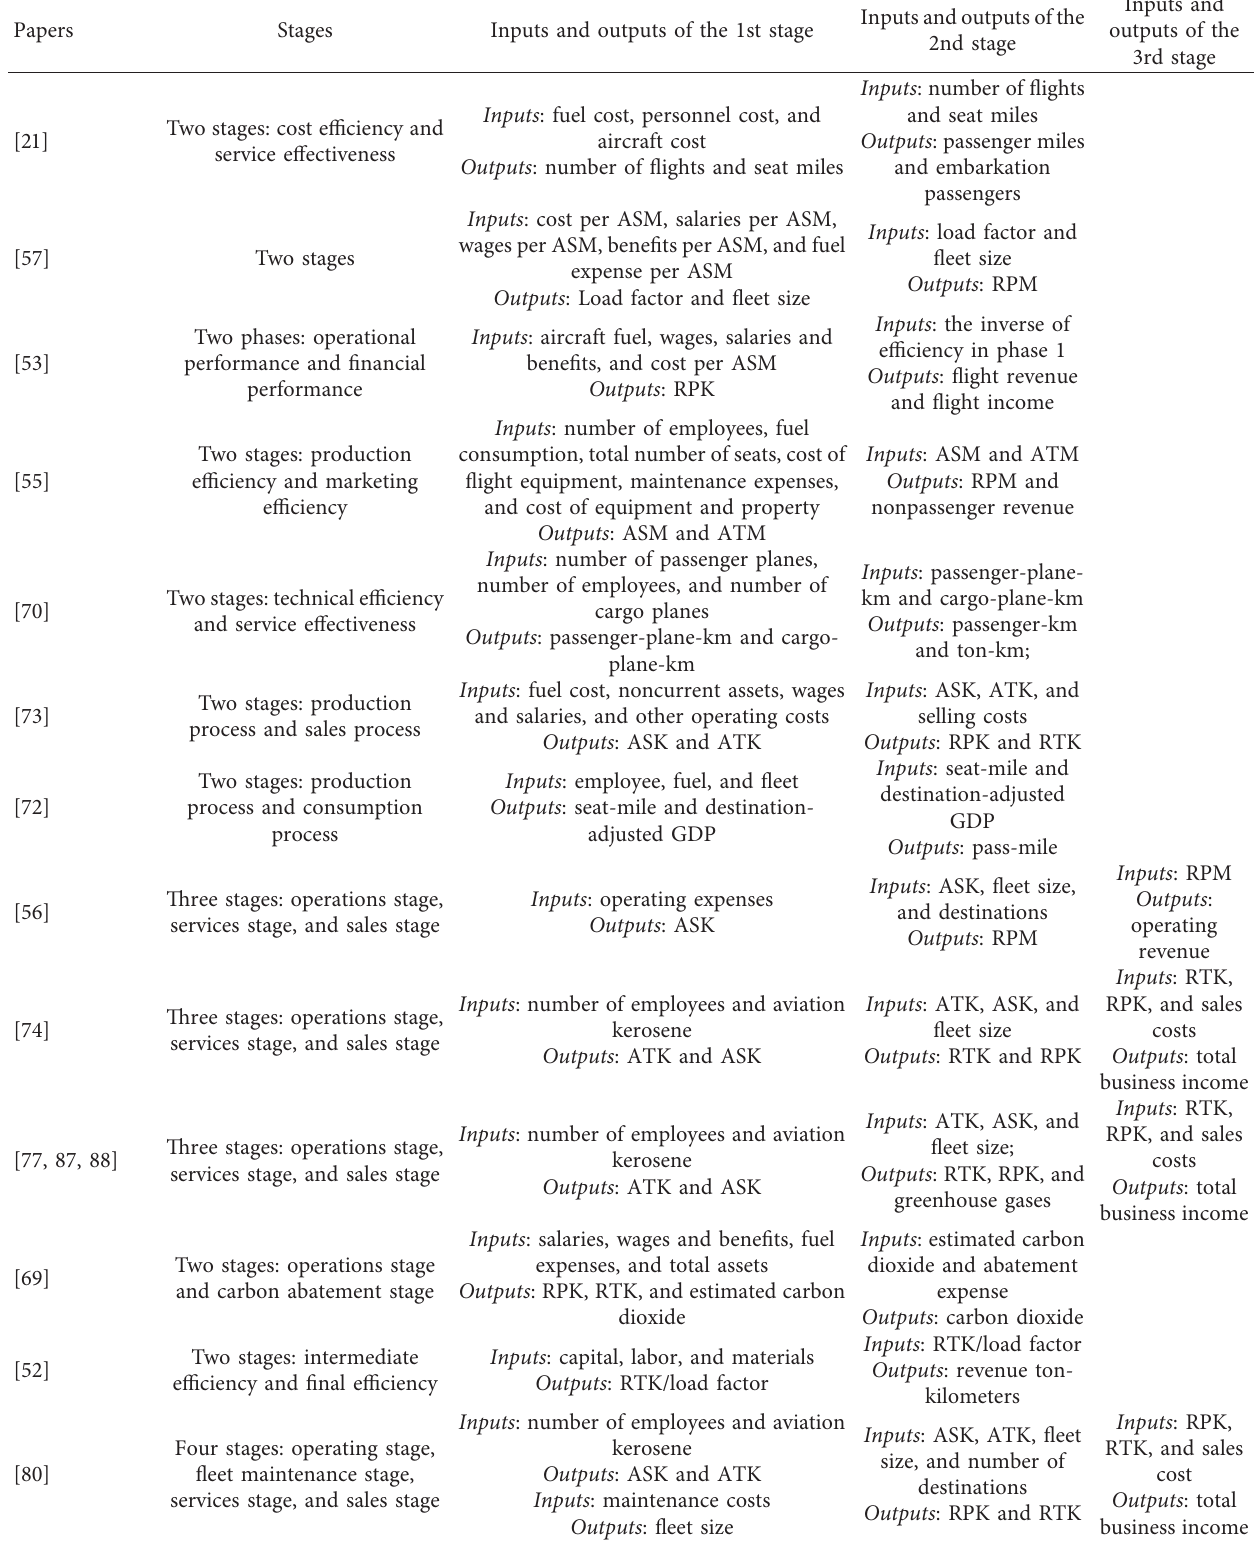
Table 5: Details of literature with network